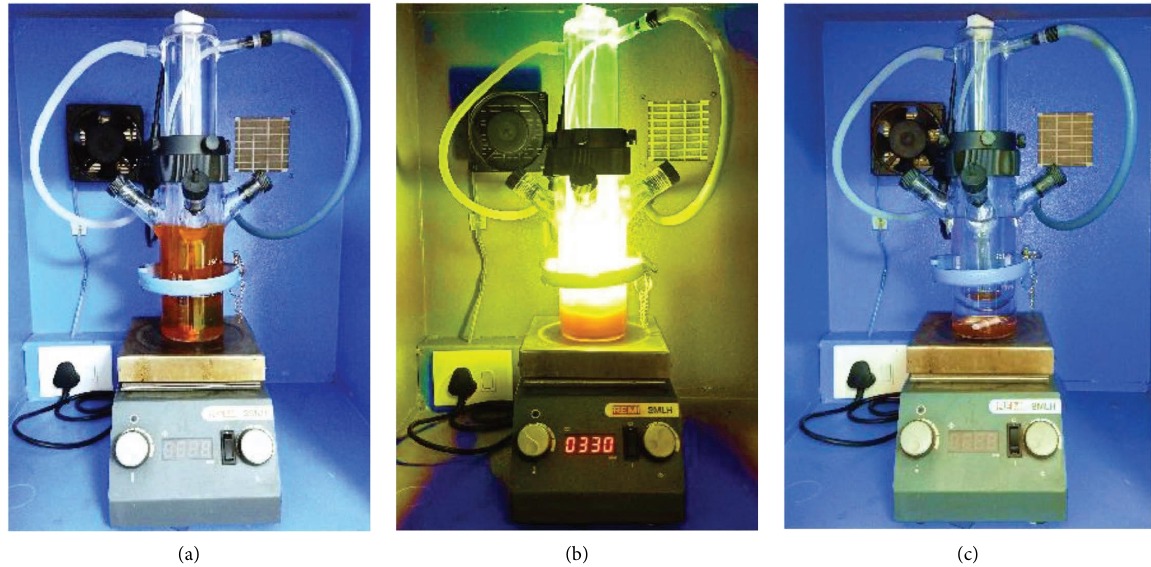
Figure 5: Photocatalytic reactor setup, (a) before treatment, (b) during treatment, and (c) after treatment of eosin yellowish dye.